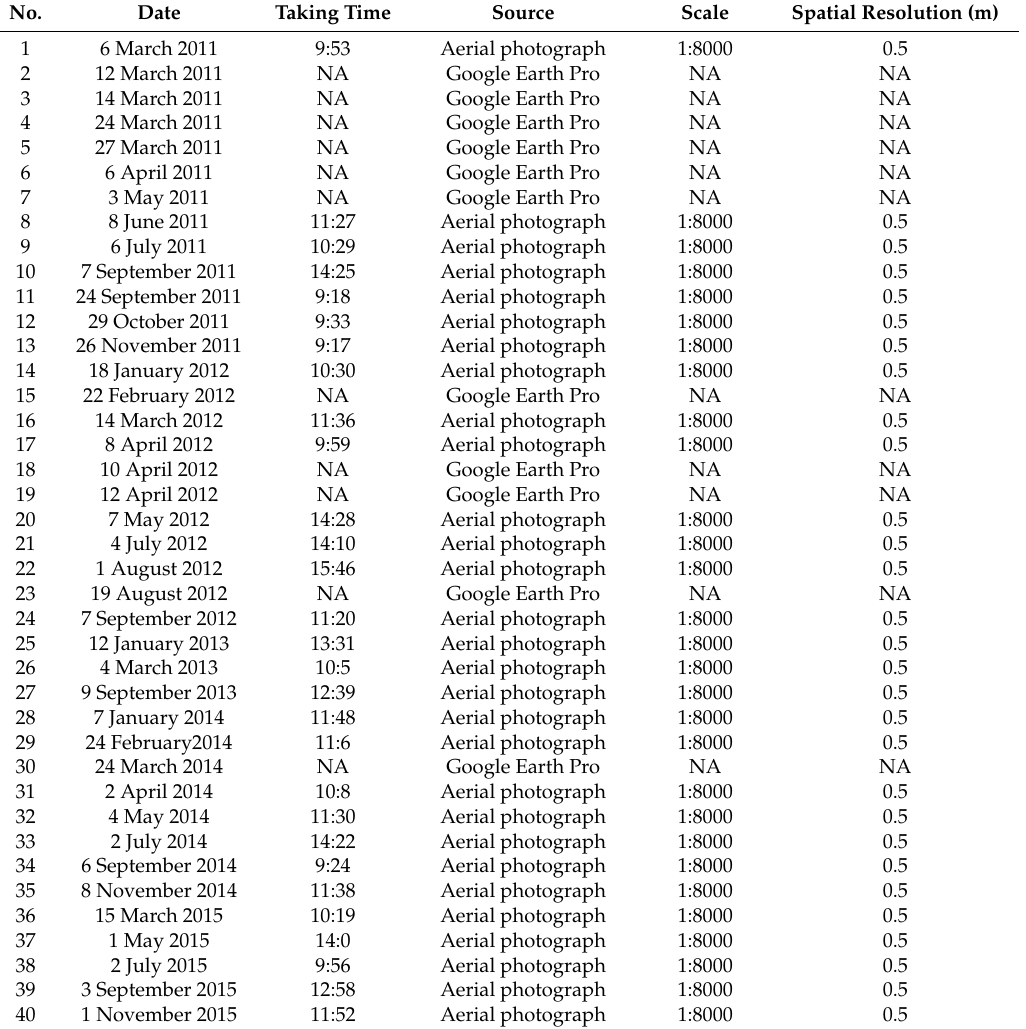
Table 2. Summary characteristics of aerial photograph and satellite